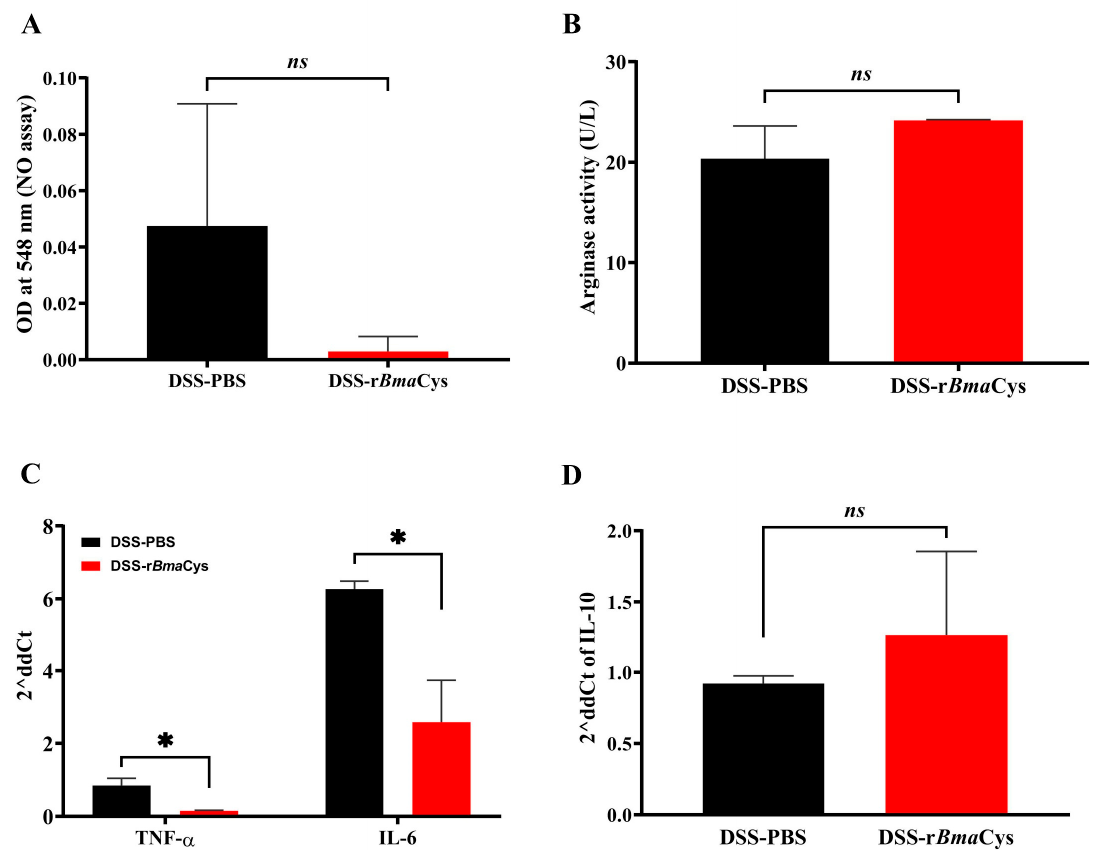
Figure 5. Activation markers were downregulated in the peritoneal macrophages collected from DSS-r Bma Cys-treated mice. Peritoneal cells from each group of mice were plated for 24 h and the culture supernatant was evaluated for levels of ( A ) nitric oxide, ( B ) arginase activity, ( C ) TNF- α and IL-6, and ( D ) IL-10. Results show that the nitric oxide levels were considerably low, but arginase 1 activity was slightly increased in the culture supernatants of plastic-adhered peritoneal macrophages collected from DSS-r Bma Cys-treated mice although the values were not significant compared to the DSS-PBS group. Total RNA isolated from the peritoneal macrophages was reverse transcribed to cDNA and expression levels (double delta CT value; 2 − ∆∆ C t ) of TNF- α , IL-6, and IL-10 were estimated after normalizing the values to the PBS control group. These results showed that TNF- α and IL-6 expression were significantly downregulated in r Bma Cys-treated mice compared to DSS-PBS control mice. The expression of IL-10 was upregulated in the peritoneal macrophages collected from DSS-r Bma Cys-treated mice, however was not significant compared to DSS-PBS group of mice and the PBS control mice (mRNA samples from male and female groups of mice were determined separately for qPCR assay and did not show any di ff erences). Each bar represents mean ± S.D. * P ≤ 0.05 compared to DSS-PBS group determined using Students’ t test. n = 10 mice per group, except the DSS-PBS group, which had 8 mice. ns = not